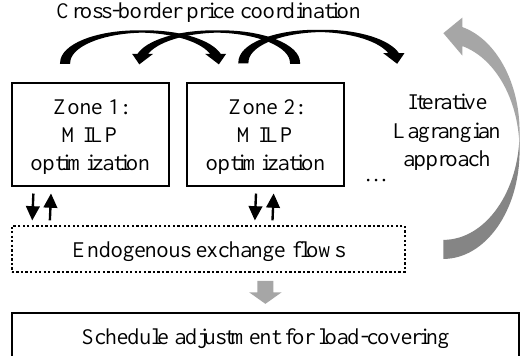
Figure 2. Process of the approach in [15] for market simulation